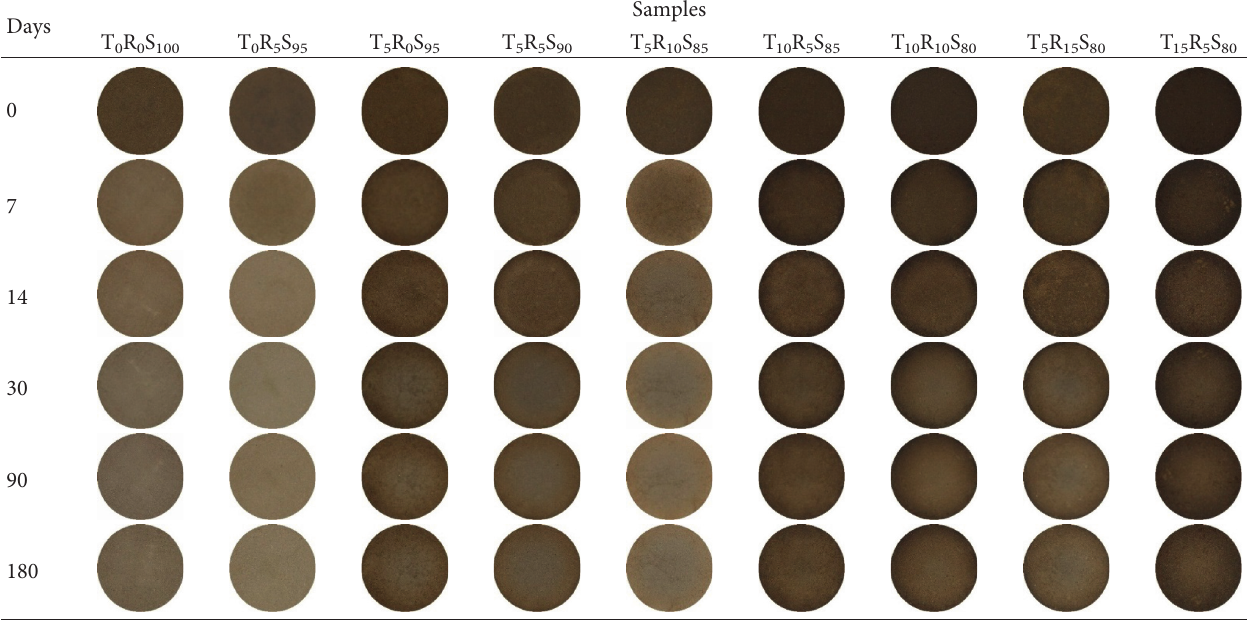
Table 4: Color contract of specimens in different mass ratio during different durations.